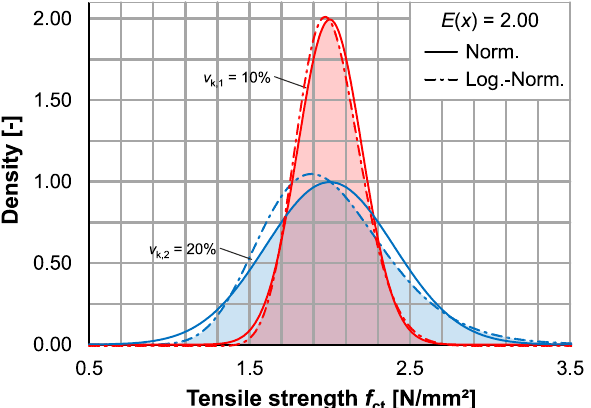
Figure 5. Comparison between the normal distribution and log-normal distribution of tensile strength, with coefficients of variation of v k = 10% and v k = 20%.